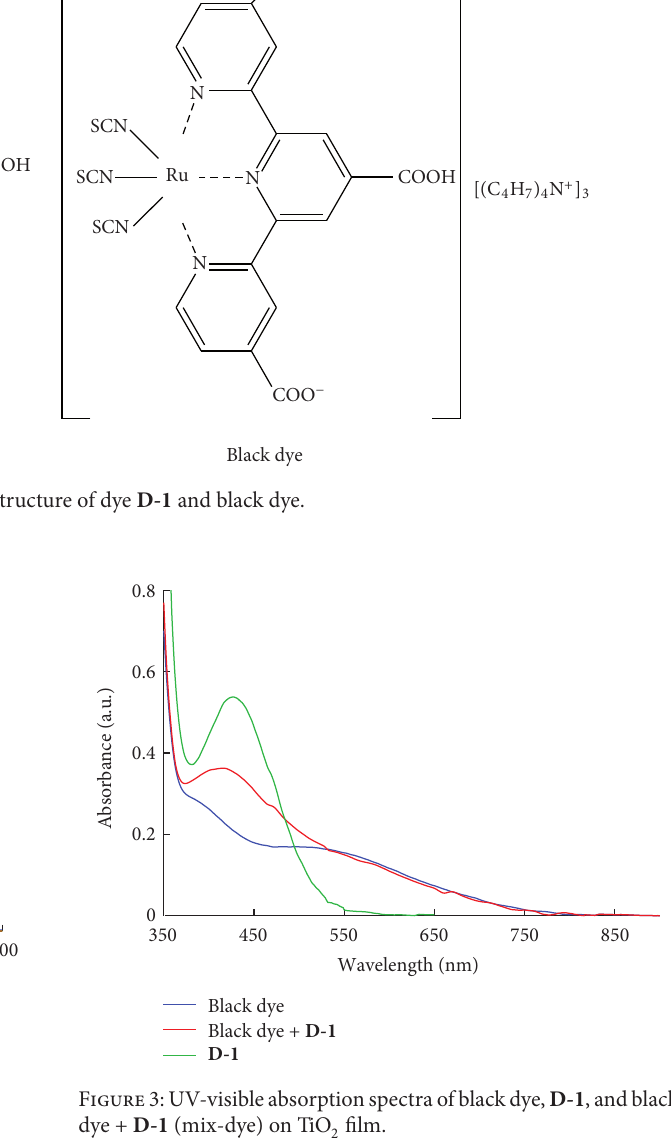
F 2: UV-visible absorption spectra of black dye, D-1 , and triiodide in ethanol solutions.